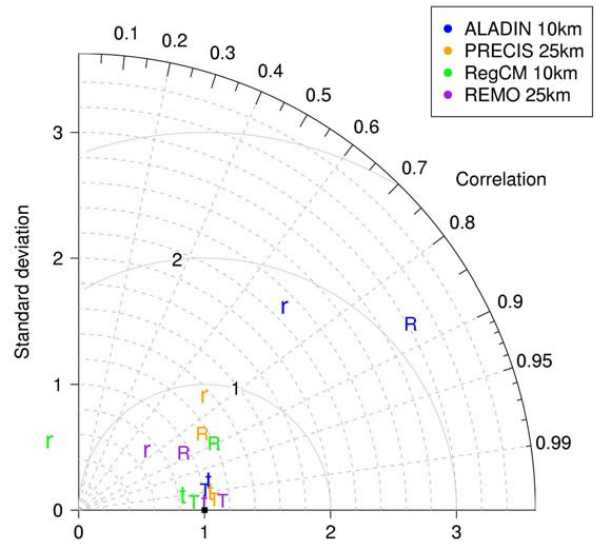
Fig. 2. Taylor diagram (normalised by the reference standard deviation) for monthly mean Figure 2. Taylor diagram (normalised by the reference standard temperature (T: ERA-40-driven case, t: GCM-driven case) and precipitation values deviation) for monthly mean temperature (T: ERA-40-driven case, (R: ERA-40-driven runs, r: GCM-driven runs) over Hungary for 1961–1990. t: GCM-driven case) and precipitation values (R: ERA-40-driven CRU data are used as observational dataset (represented by black dot). runs, r: GCM-driven runs) over Hungary for 1961–1990. CRU data are used as observational dataset (represented by black dot).